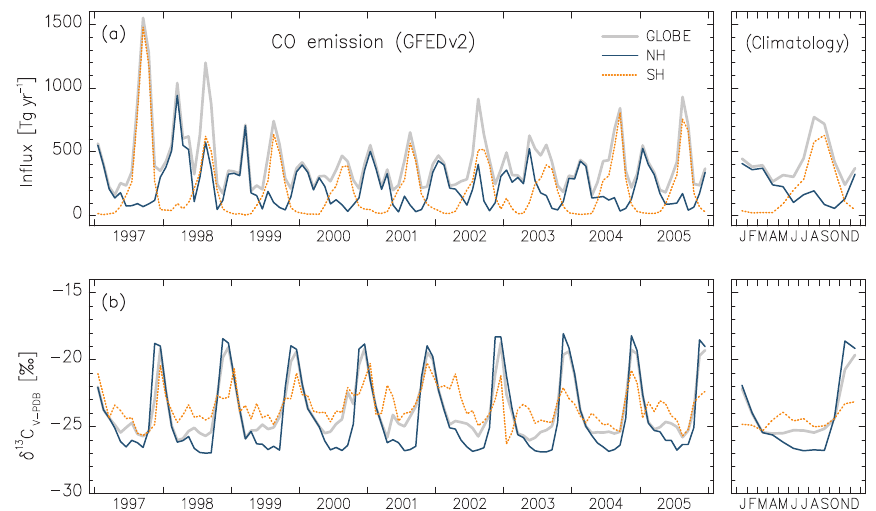
Figure 4. Emission of CO from biomass burning sources based on the GFED v2.1 data. (a) CO integrated flux in the Northern Hemisphere (NH), Southern Hemisphere (SH) and globally. (b) The carbon isotope composition of the respective fluxes. The right panels depict the climatological ensemble averages (shown in Fig.